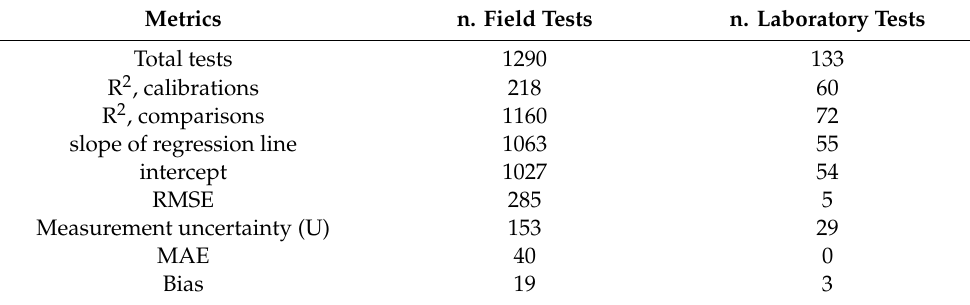
Table 2. Number of records gathered by metrics available in